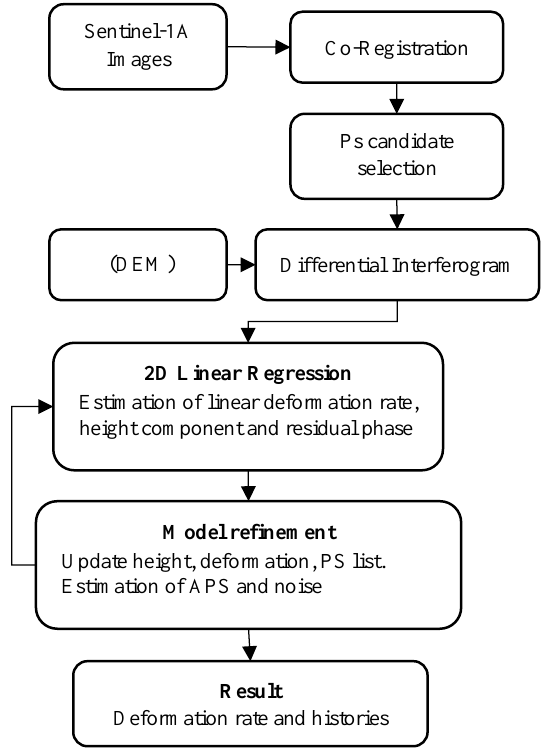
Figure 5. Fitting the two-dimensional regression model. The red line represents the regression line and the blue crossed points show the interferometric phase difference of a point and reference one in a stack of 27 Sentinel-1A interferograms. The upper plot shows the dependence of the phase to the spatial baseline corresponding to the topographic effect and the lower plot shows a temporal phase trend related to the deformation.